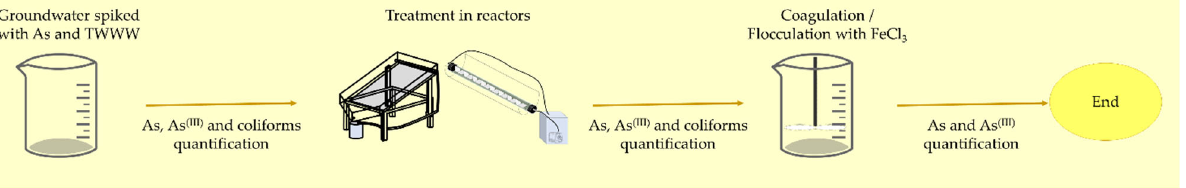
Figure 3. Process flow